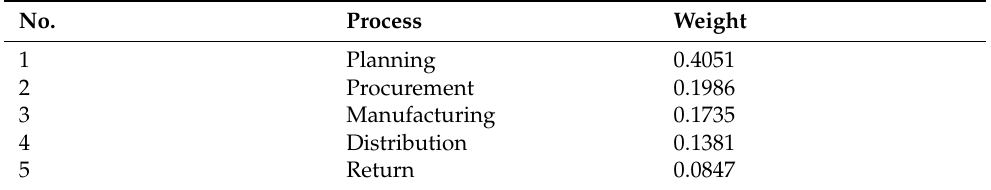
Table 6. Weighted results by process.